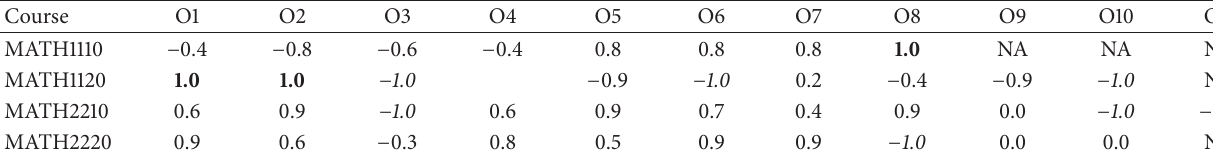
Table 9: Correlations between direct and indirect measures.